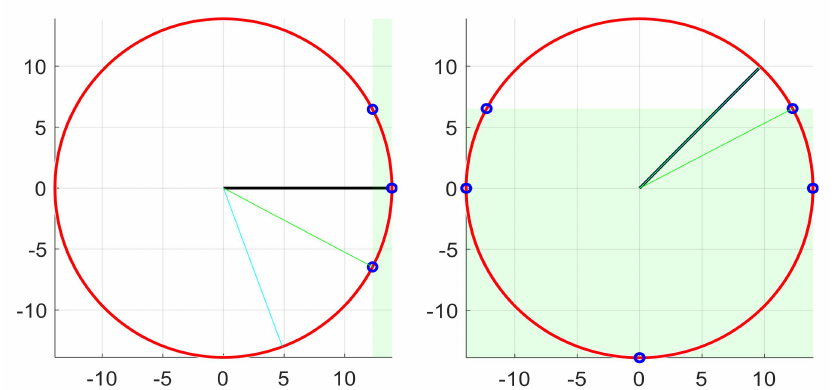
Figure 9. Choosing the best velocity among the candidate points. In both cases, the red circle delimits the maximum velocity; the green box defines the set of valid velocities; the black radius indicates the current velocity; the blue radius indicates the direct velocity to the destination; the green radius indicates the velocity finally selected for the next time